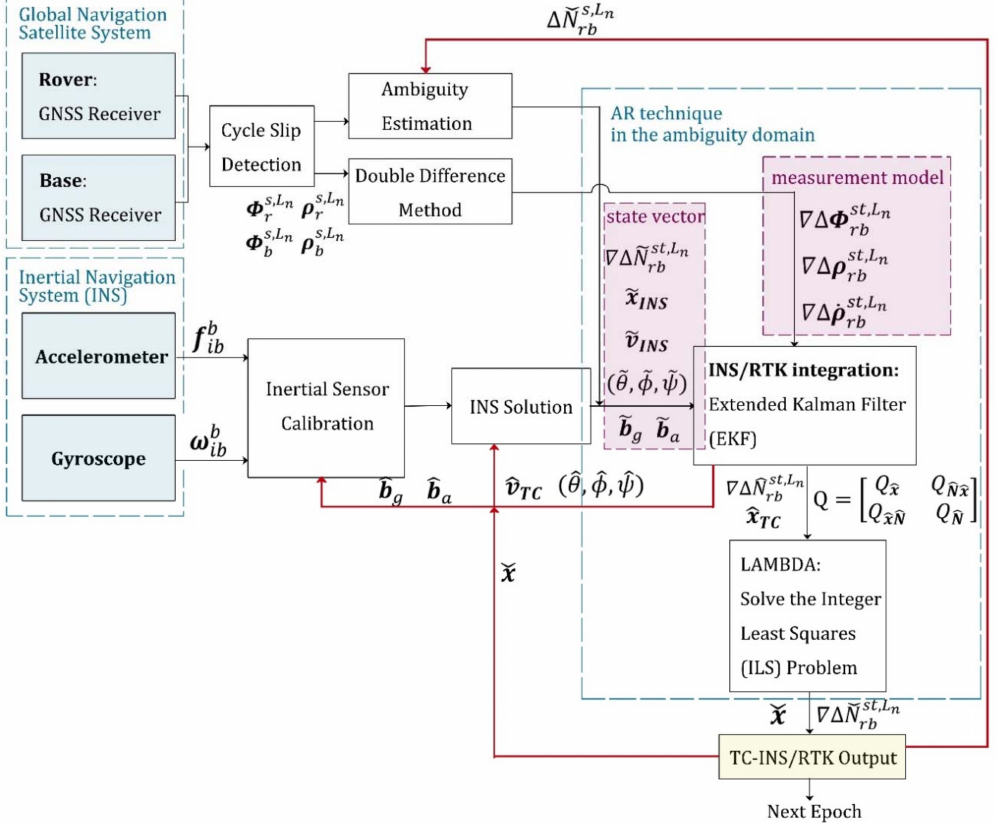
Figure 1. The first implementation of tightly-coupled Inertial Navigation System (INS)/real-time kinematic (RTK) integration using an extended Kalman filter